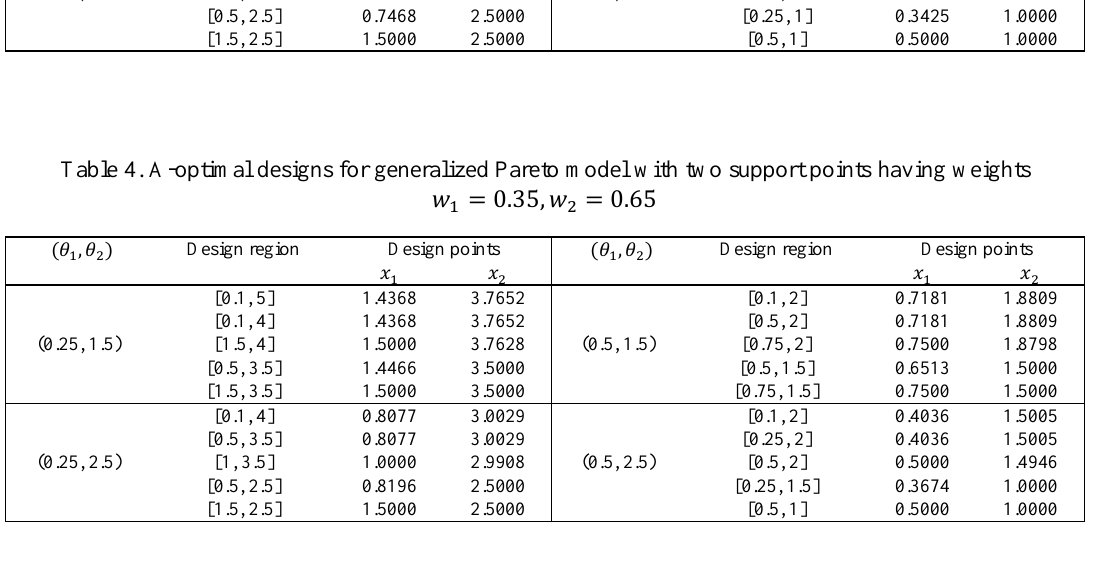
Table 4. A-optimal designs for generalized Pareto model with two support points having weights